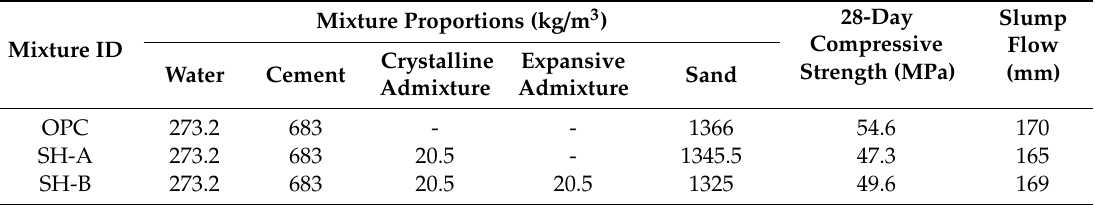
Table 2. Mixture proportions, slump flow, and compressive strengths of the test